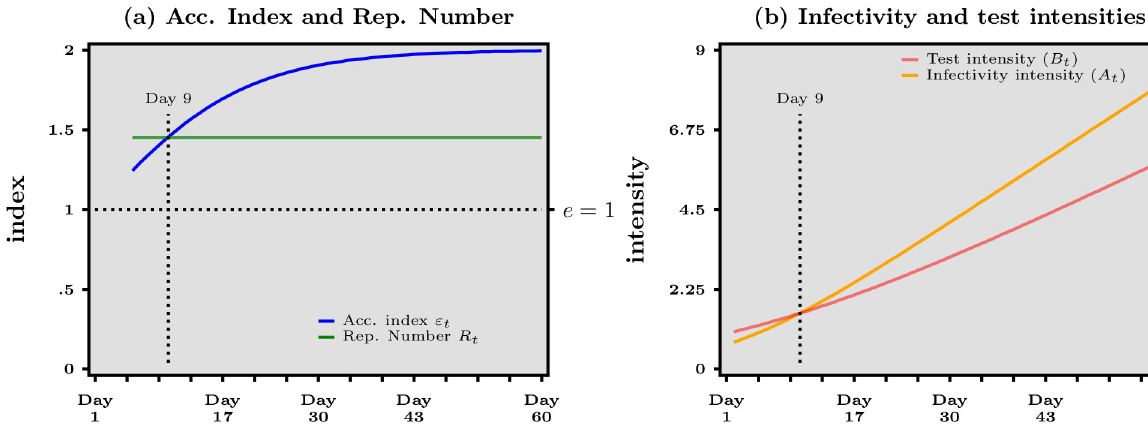
Fig 2. Numerical example for exponential growth of both daily cases and daily tests. Panel ( a ) Acceleration index (blue curve) and Reproduction number (green curve). Panel ( b ) Infectivity intensity (orange curve) and Test intensity (red curve).